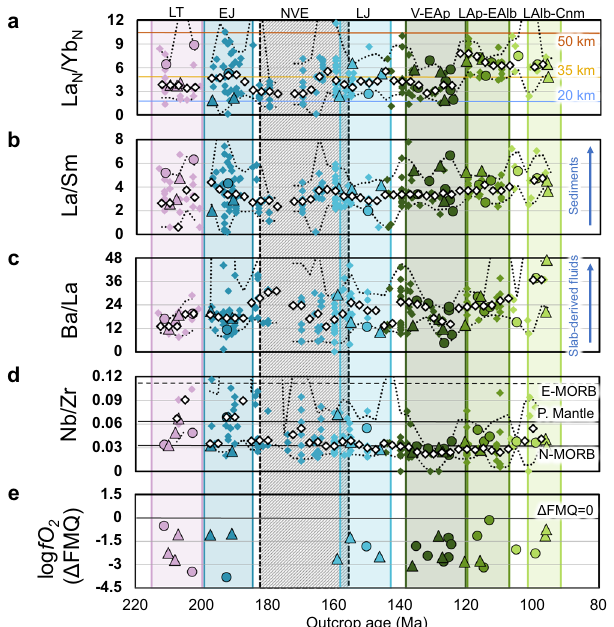
Fig. 2 Whole-rock petrogenetic indicators. The geochemical data are used to estimate the following parameters: a crustal thickness 41 . b , c Sediment and slab-derived fl uid contributions to the magma source 4 . d Enrichment of the magmatic source 4 . Reference values for N-MORB, Primitive Mantle (P. dashed grey band. (iii) Ti-in-zircon temperatures (Fig. 3b), which could be linked to magma composition, depth of emplacement and cooling rates in determined by whole-rock La/Sm, Ba/La and Nb/Zr 4 and zircon U/Yb 13 elemental ratios (Fig. 2b – d and Fig. 3c, respectively). The Ce/Nd ratios (Fig. 3d, e). It is also calculated by using rock-to- zircon elemental partitioning coef fi cients 46,47 and expressed in fayalite – magnetite – quartz mineral buffer ( Δ FMQ) (Fig. 2e). To discern trends and/or anomalous values, the median and 5th and 95th percentiles were calculated using a kernel density estimation with a bandwidth of 2.5 Ma and a bin width of 5 Ma for each series, except for the oxygen fugacity due to the limited number of samples with zircon and whole-rock analyses ( n = 30). In addi- tion, the median and 5th and 95th percentiles for the 10 petro- genetic indicators and by each plutonic episode are reported in Supplementary Table 3.